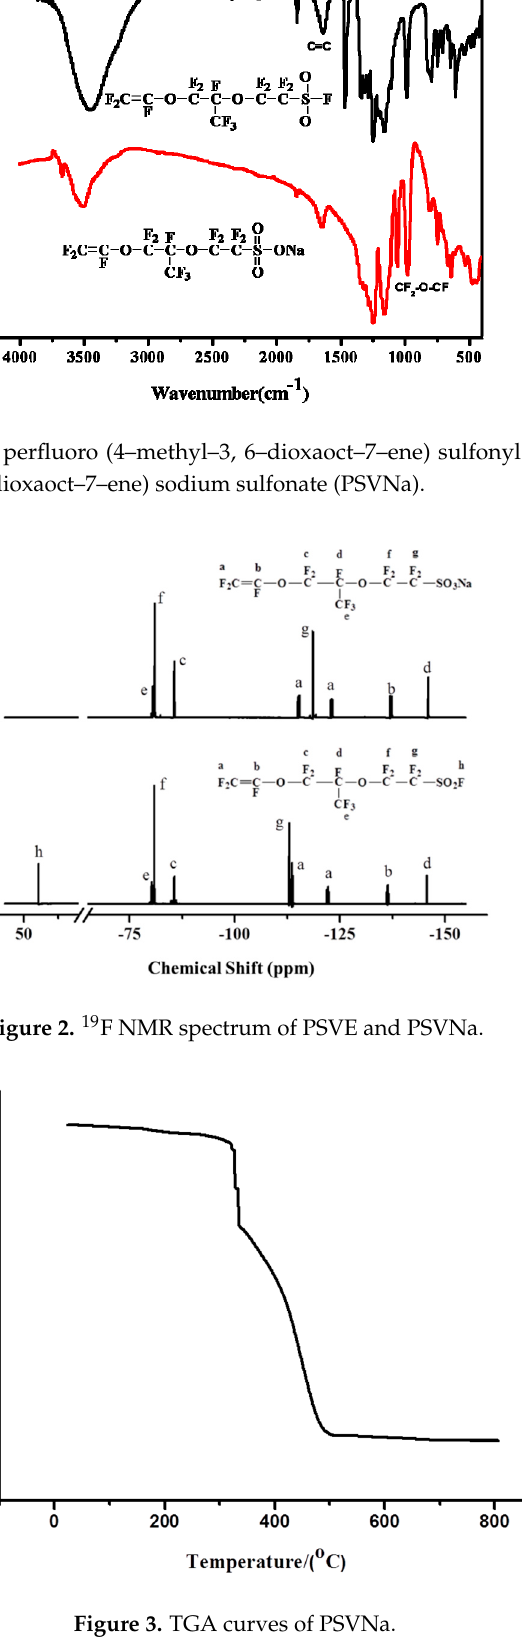
Figure 3. TGA curves of PSVNa.